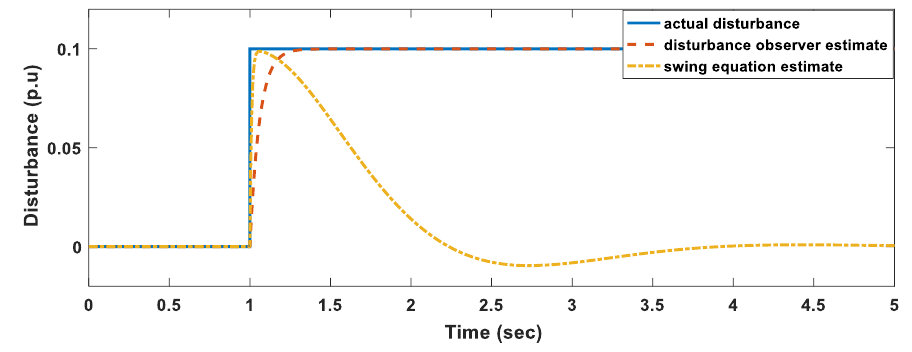
Figure 14. Scenario 3 disturbance observer vs swing equation estimation.